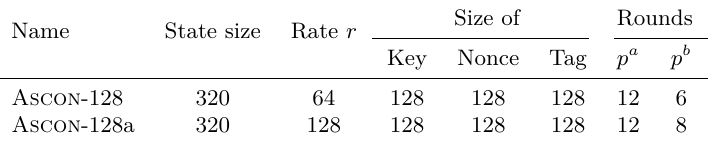
Table 2: Ascon variants and their recommended parameters